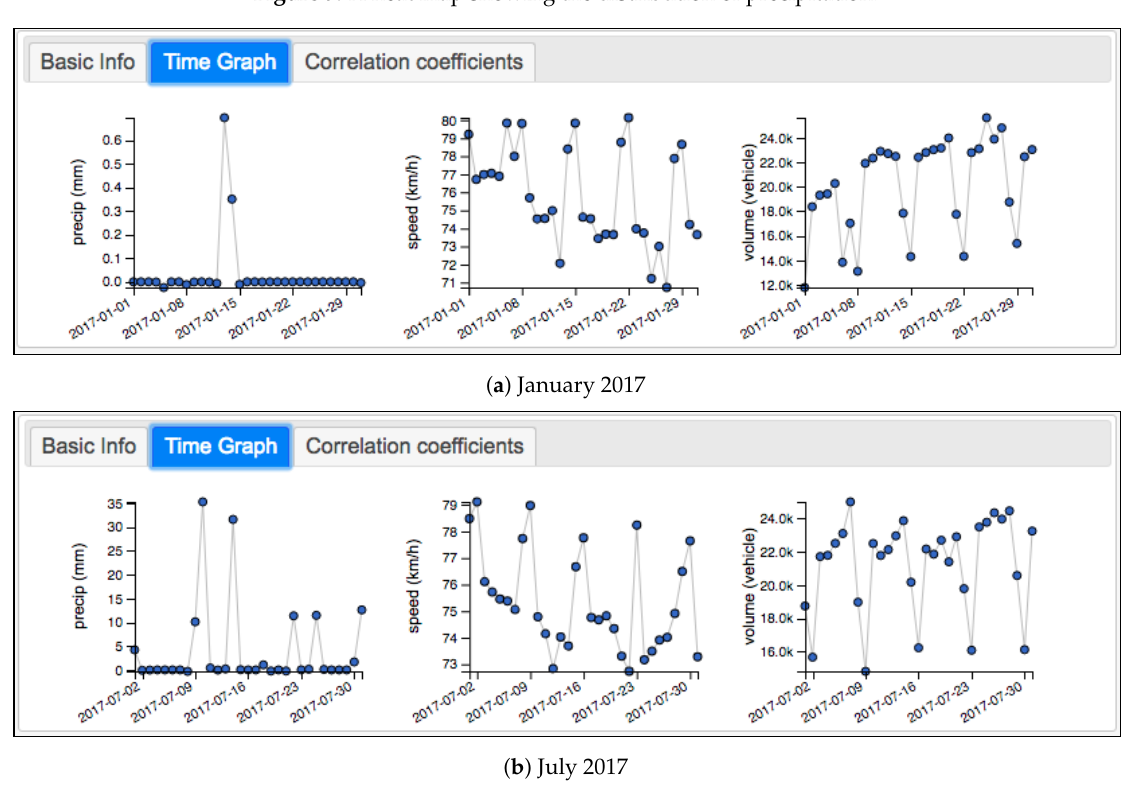
Figure 9. A heat map showing the distribution of precipitation.